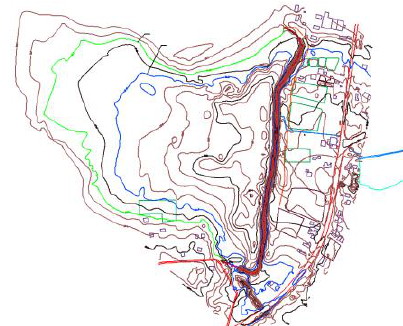
Figure 8: Contour Map